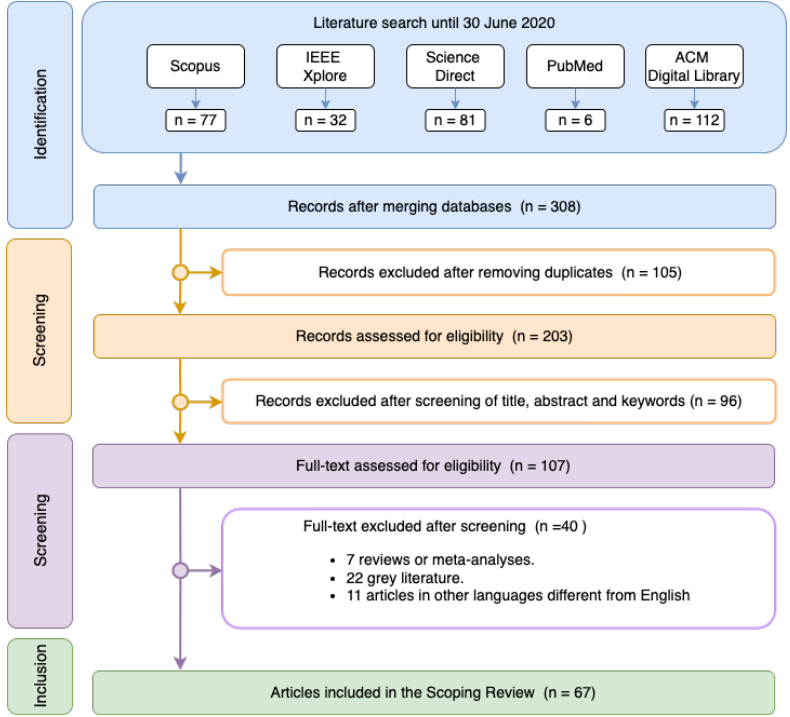
Figure 1. Search